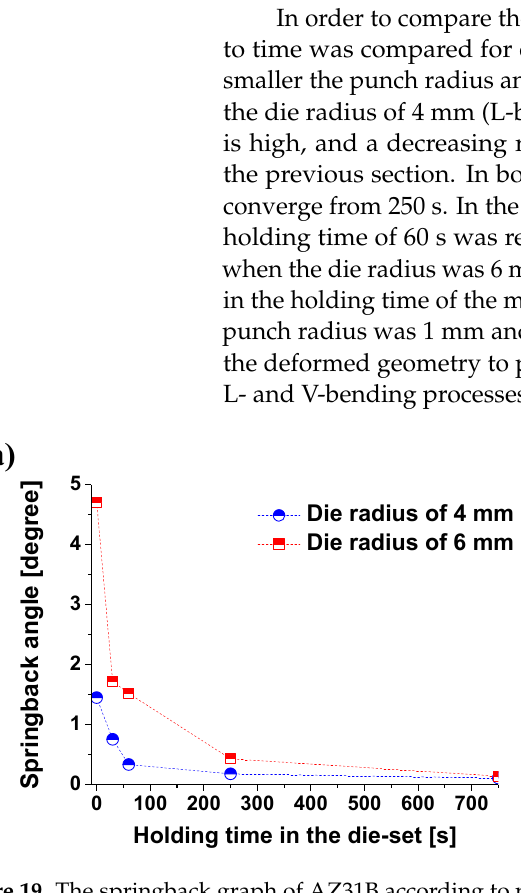
Figure 19. The springback graph of AZ31B according to punch radius and time on 250 °C during the ( a ) L-bending and ( b ) V-bending processes.